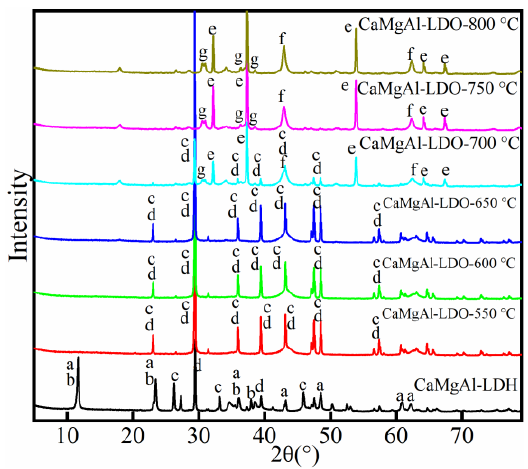
Figure 1. XRD patterns of as-prepared CaMgAl-LDHs calcined at different temperatures from 550 °C to 800 °C. ( a ) Mg 0.677 Al 0.333 (OH) 2 (CO 3 ) 0.167 ·0.5H 2 O; ( b ) Ca 0.68 Al 0.32 (OH) 2 (CO 3 ) 0.16 ·0.47H 2 O; ( c ) CaCO 3 ; ( d ) Mg 0.03 Ca 0.97 (CO 3 ); ( e ) CaO; ( f ) MgO; ( g ) Ca 5 Al 6 O 14 .